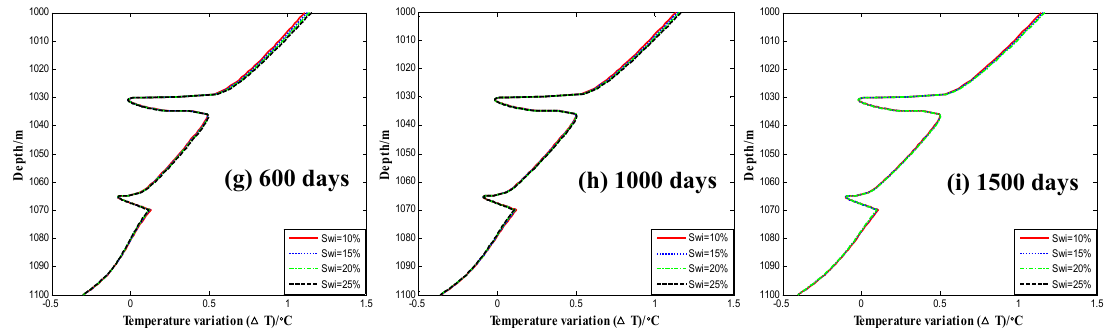
Figure 20. Formation temperature variation at the wellbore-formation interface ( r = 0.14 m, 1000 m ≤ z ≤ 1100 m) with different irreducible water saturations ( s wi ). ( a )–( i ) represent the temperature profiles from 1 day to 1500 days.